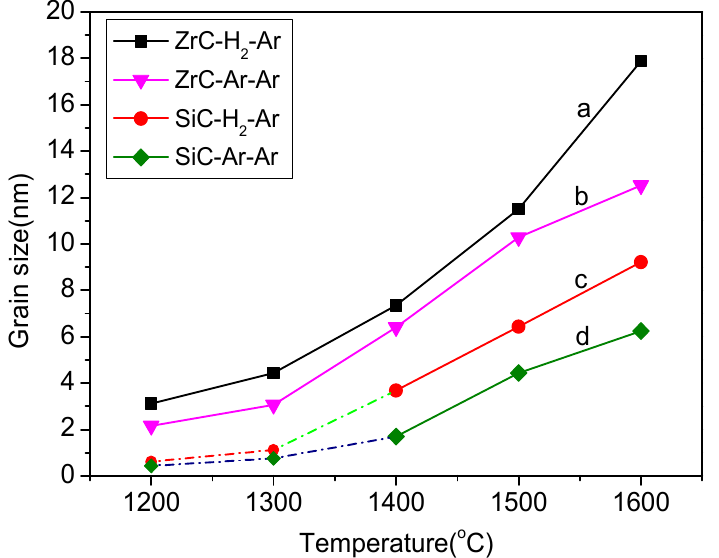
Figure 7. Crystalline grain sizes of ZrC ( a , b ) and SiC ( c , d ) in the composite fibers after pyrolysis at 1000 °C and annealing at various temperatures from 1200 to 1600 °C ( a , c : H 2 –Ar process; b , d : Ar–Ar process).